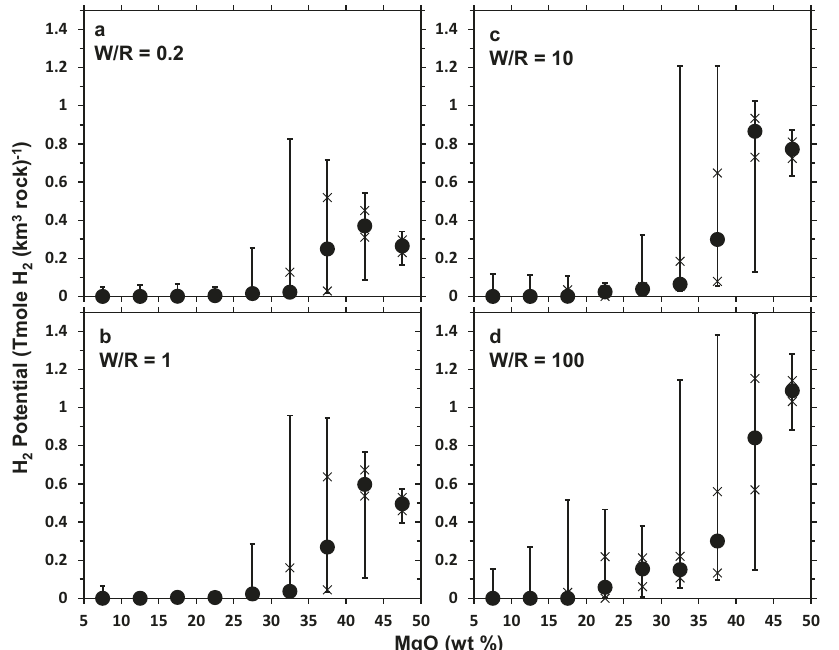
Fig. 2 Summary of H 2 -generation potentials of various rock compositional groups. Median (circle), 25th – 75th percentile (lower and upper Xs, respectively), and 5th – 95th percentile (lower and upper ticks, respectively) of H 2 -generation potentials yielded by simulations of alteration at various water-to-rock ratios: a 0.2, b 1, c 10, d 100 for various 5 wt % ranges of MgO content (e.g., 30 – 35